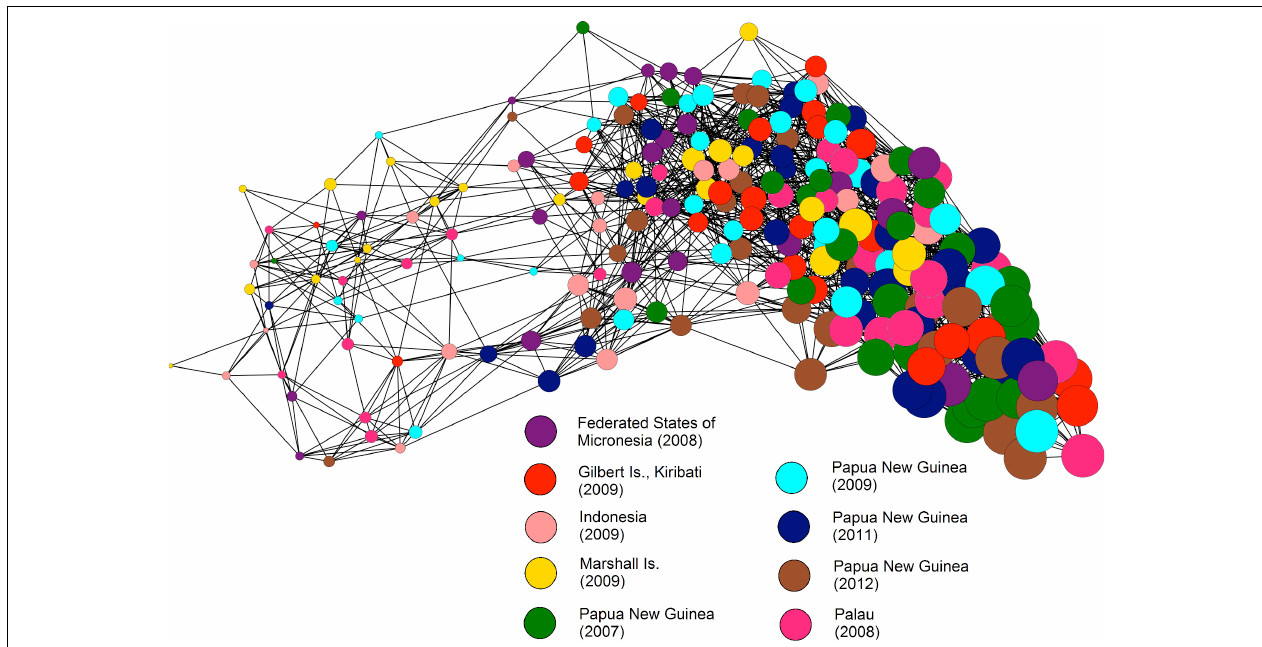
FIGURE 3 | Fine-scale population genetic structure network analyzed using Netview R at mk-NN = 24. Node sizes displayed are mapped to the relatedness of individual fish, where larger node diameters denote higher levels of relatedness.